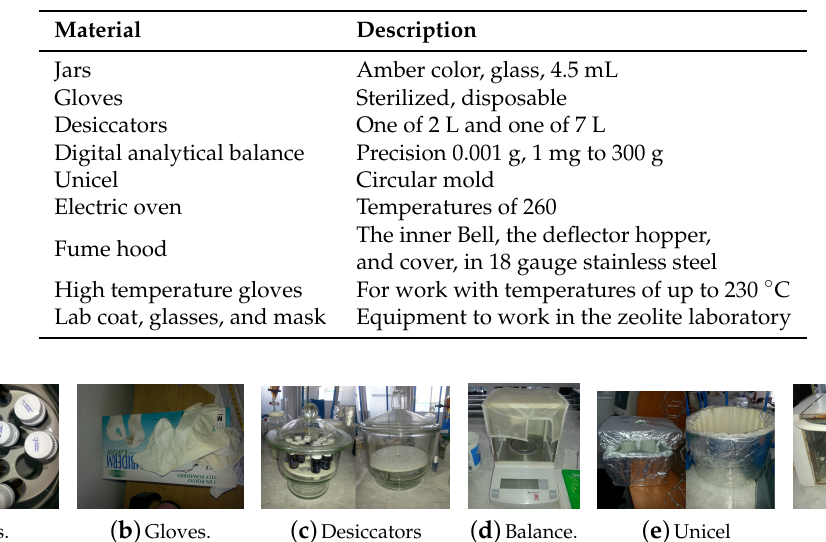
Table A1. Work materials to perform the experiments.